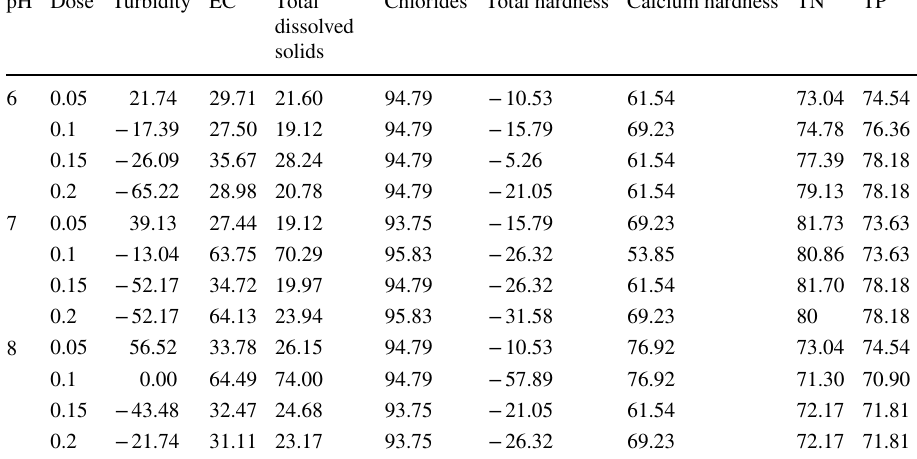
pH Dose Turbidity